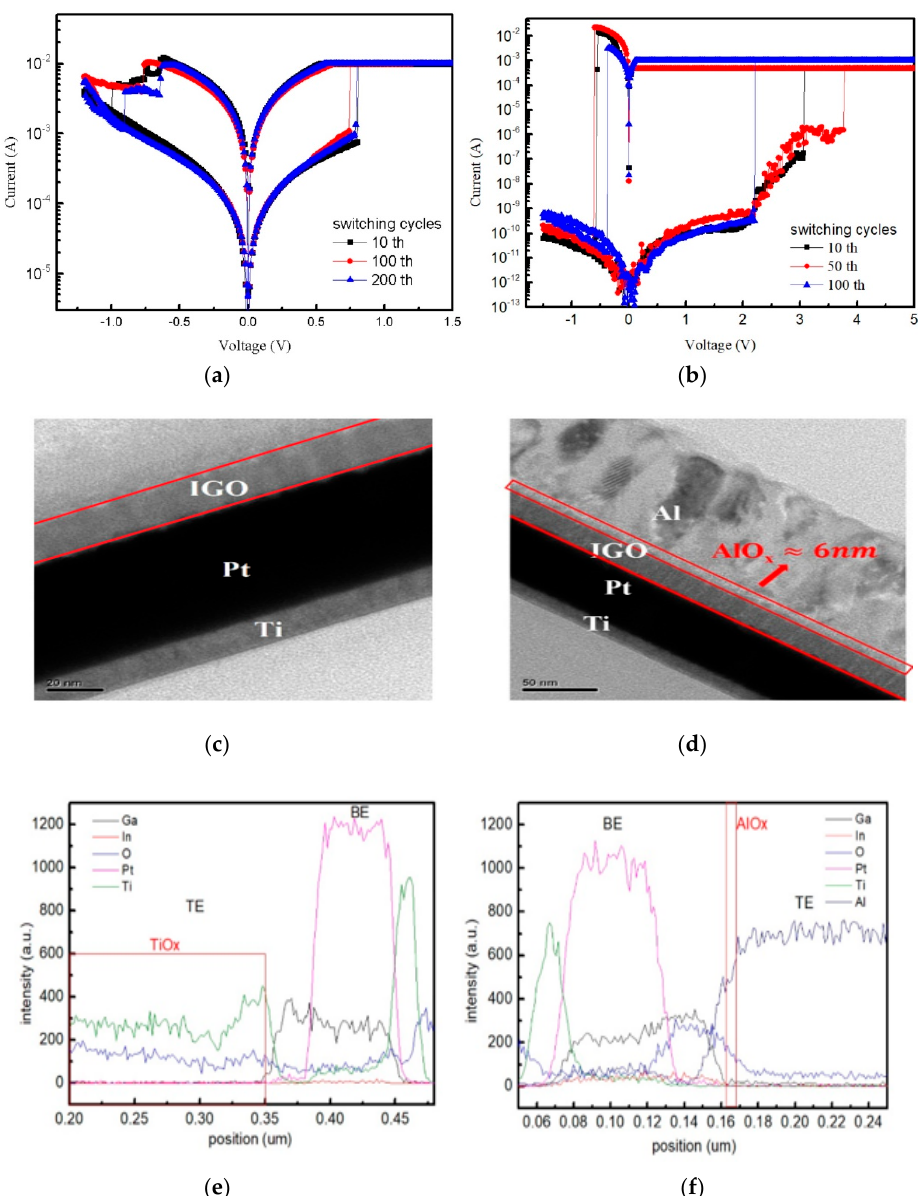
Figure 4. IV sweep curve of IGO RRAM with TE of ( a ) Ti and ( b ) Al. Cross section from TEM result of IGO RRAM with TE of ( c ) Ti and ( d ) Al. Line scan profile of IGO RRAM with TE of ( e ) Ti and ( f ) Al. Different from Pt as TE metal, both Ti and Al will form an oxidation layer and further affect the conductive mechanism of the RRAM device. Figure 5 indicates the conductive mechanism of RRAM with Ti and Al. When a positive bias was applied to the Ti TE, the TiO x acted as a reservoir of oxygen ions, which assists to form sturdy filaments in the switching layer. Consequently, low set voltage and reset voltage are obtained. On the contrary, when a positive bias was applied to the Al TE, the reset process is distinguished from that of Ti. Since we already realized that the Al-O bond is hard to break, the rupture of the conductive filaments is then dominated by the Joule heat effect, which causes significantly higher current during the reset process than the set process as shown in Figure 4b.